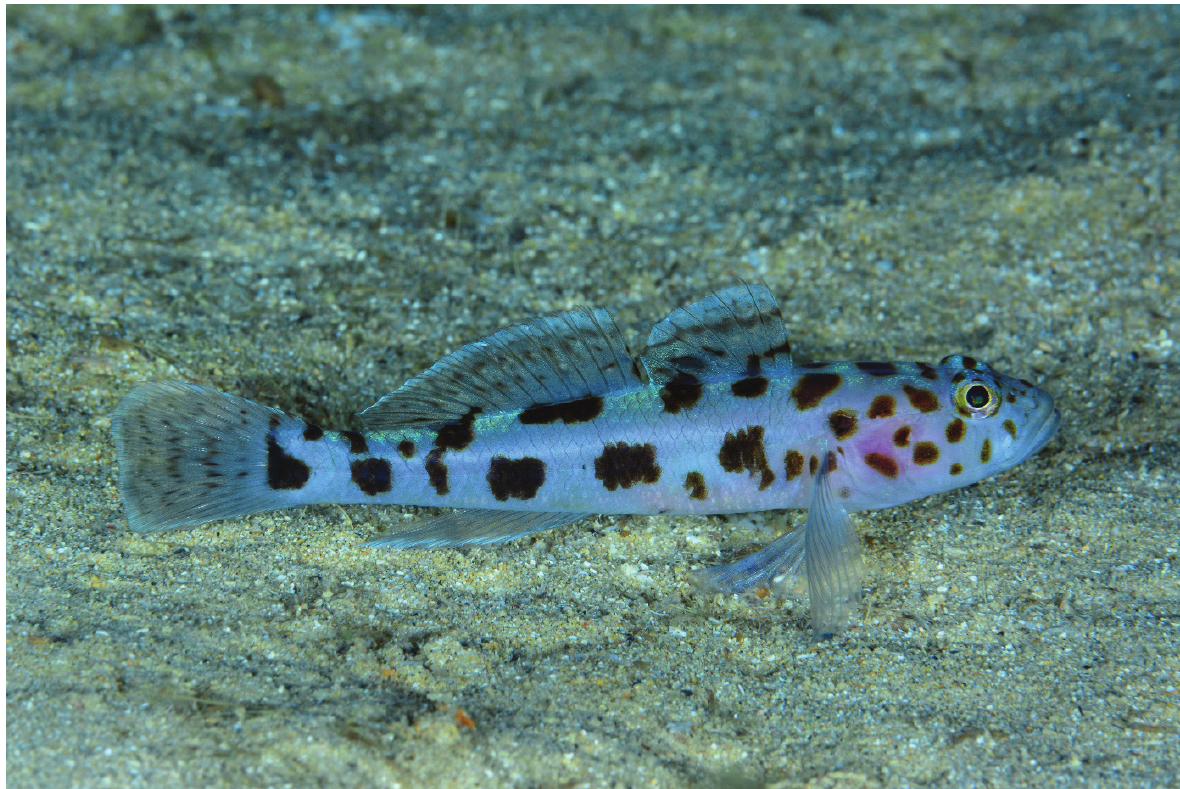
Figure 1. Photograph of Thorogobius ephippiatus , taken on 27 June 2016 at a depth of 24 m within a cave (36º04.879′N, 014º14.110′E). Photograph: OCEANA/Carlos Minguell © LIFE BaĦAR for